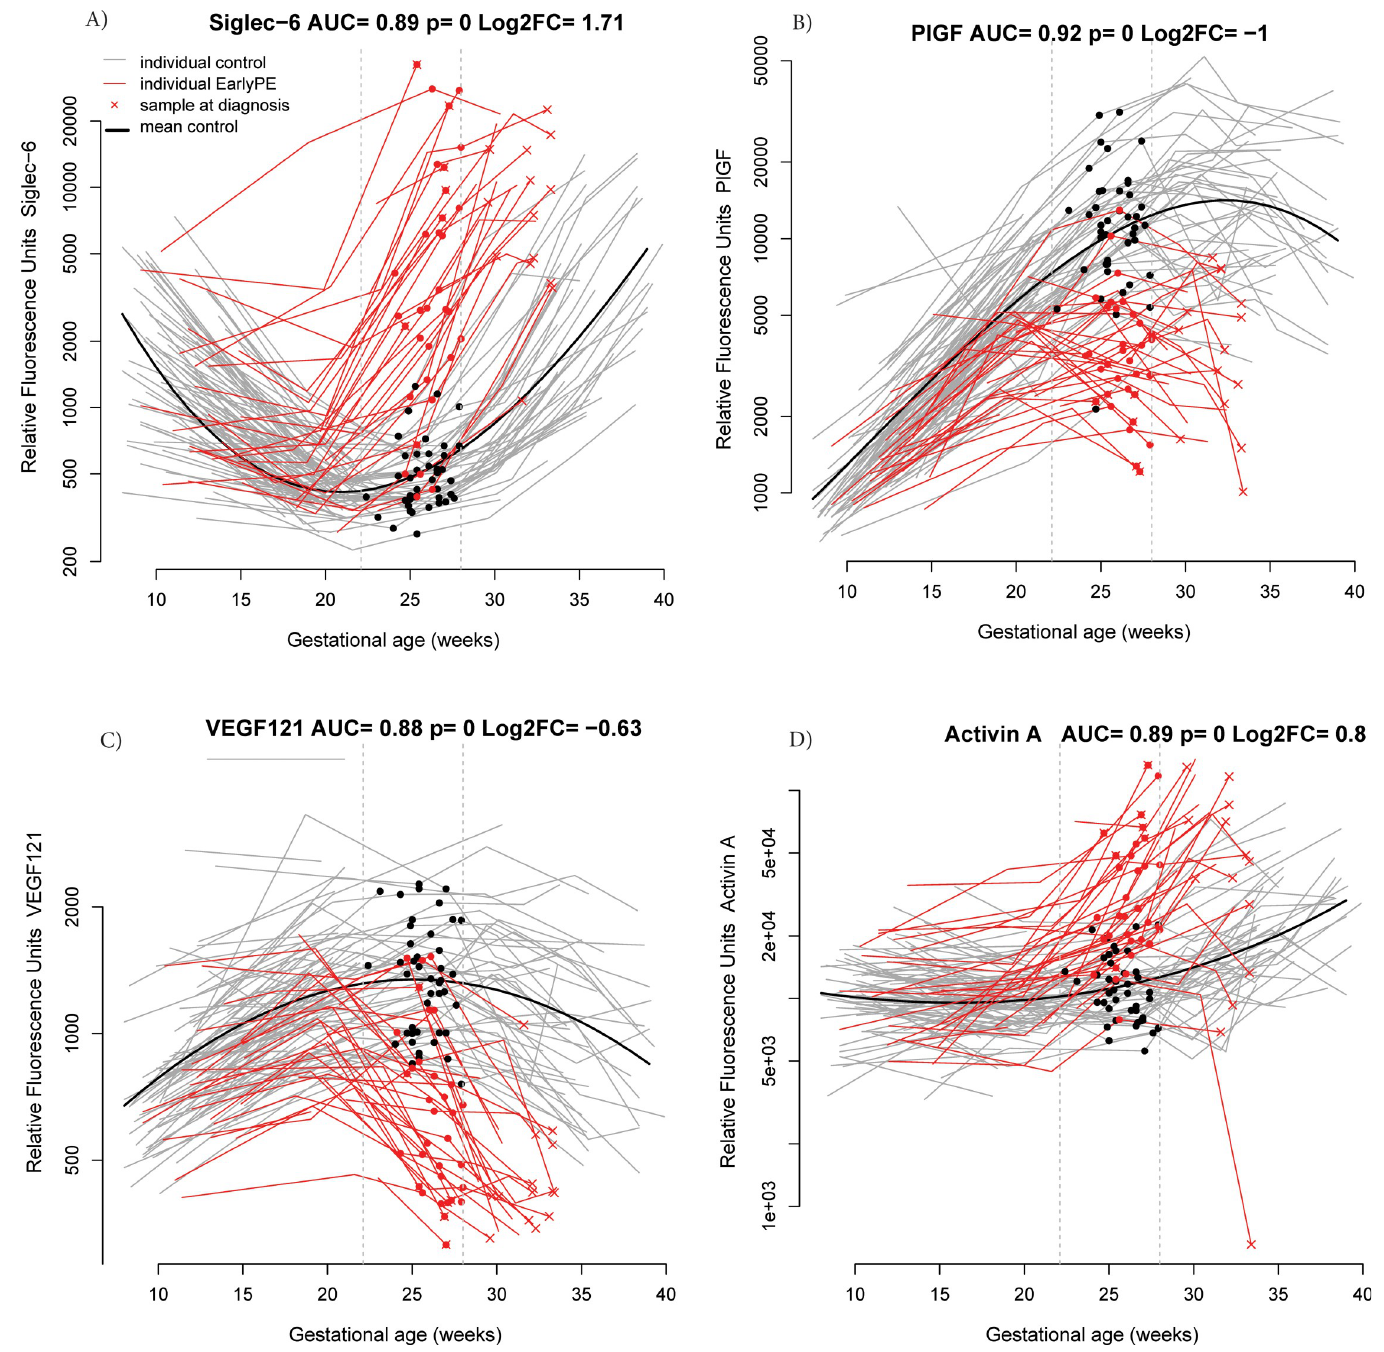
Fig 3. Longitudinal maternal plasma abundance of siglec − 6 (A), PlGF (B), VEGF121 (C), and activin-A (D) in normal pregnancy and early preeclampsia cases, highlighting differences at 22.1–28 weeks. AUC: area under the receiver operating characteristic curve; early PE: early preeclampsia; FC: fold change; PlGF: placental growth factor; Siglec-6: sialic acid binding immunoglobulin-like lectin; VEGF121: vascular endothelial growth factor A, isoform 121.